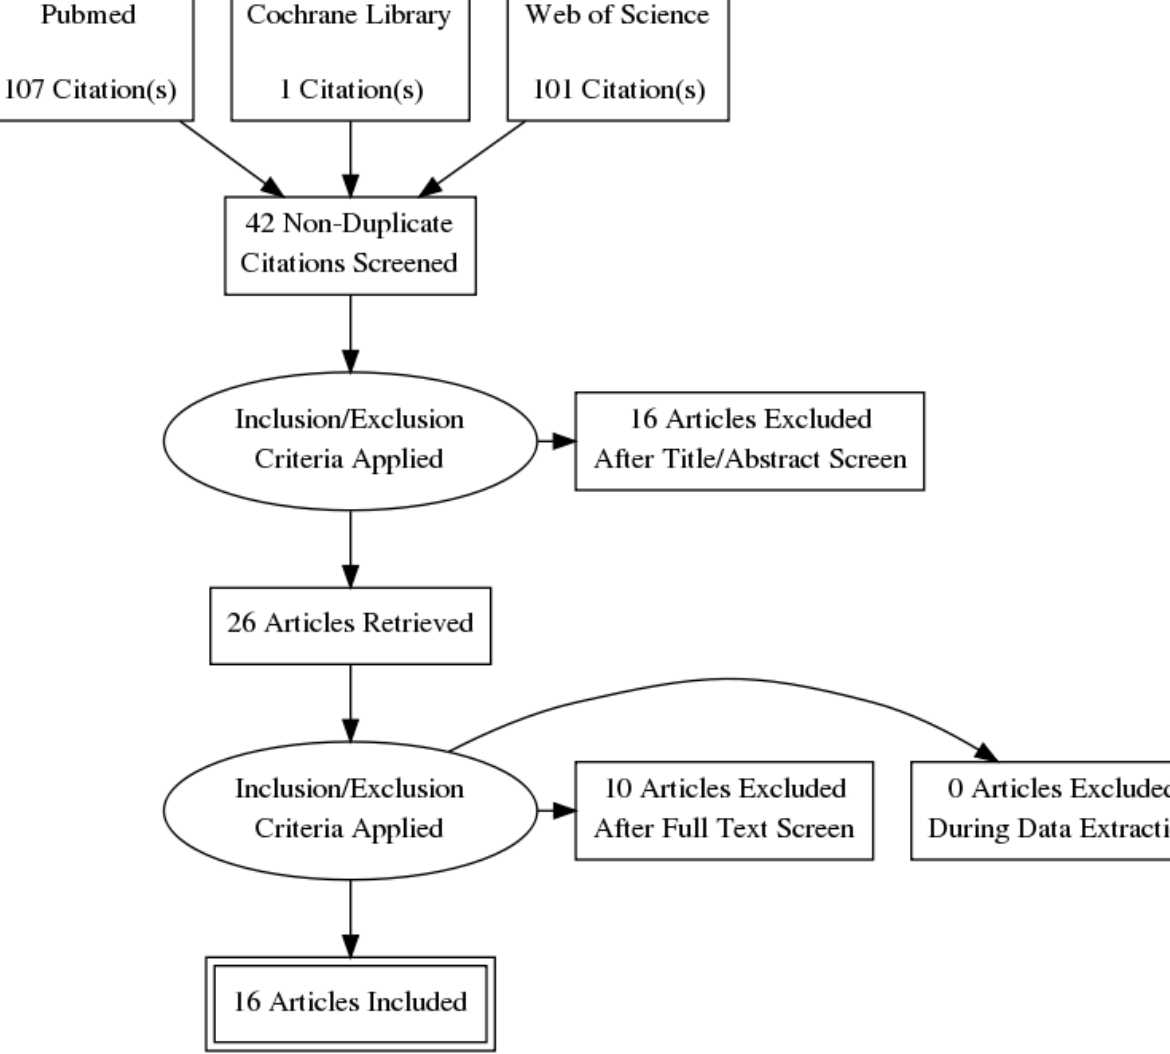
Figure 1. PRISMA flow diagram of article selection criteria.